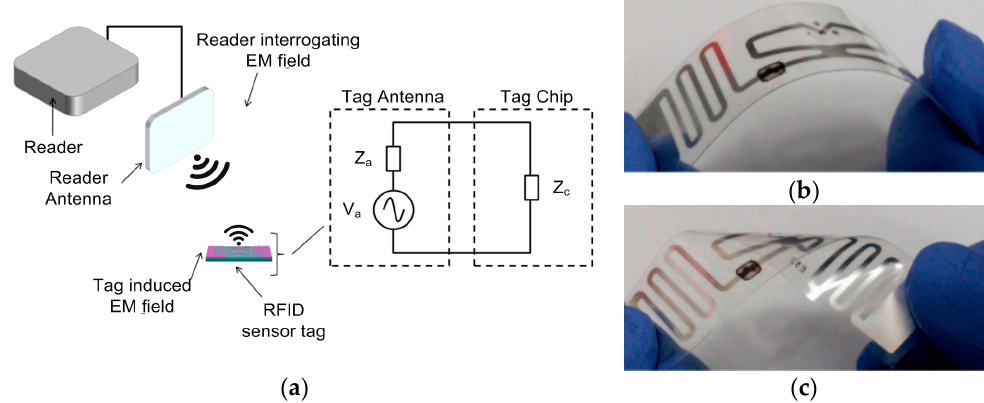
Figure 11. RFID system for wireless hydrogen sensing platform. ( a ) Schematic diagram of the ultrahigh-frequency (UHF)- RFID sensor tag and antenna and circuit diagram in RFID sensor tag; ( b ) bending; and ( c ) twisting of the RFID sensor tag immobilized rGO/Pt (reprinted permission from [85]).